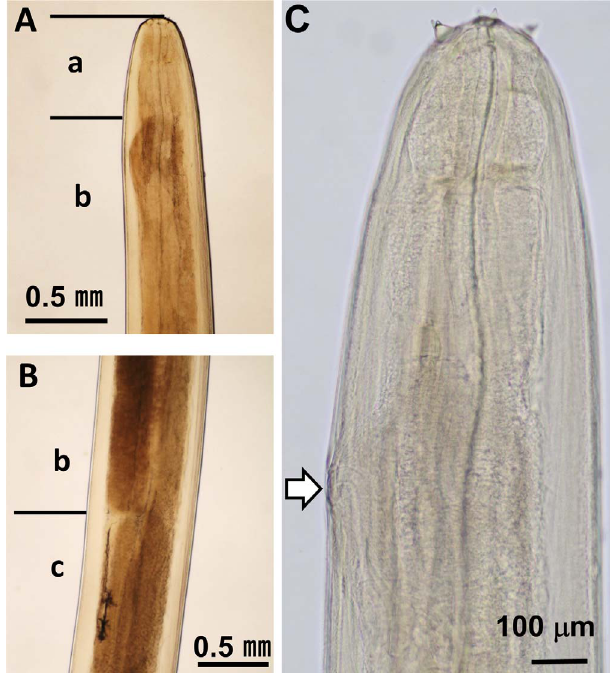
Figure 2. Esophagus of a nematode. (A) The border between (a) the muscular and (b) the glandular part of the esophagus. (B) The border between (b) the posterior end of the glandular part of the esophagus and (c) the intestinal canal. (C) The anterior esophagus of a female. Arrow indicates the vulval